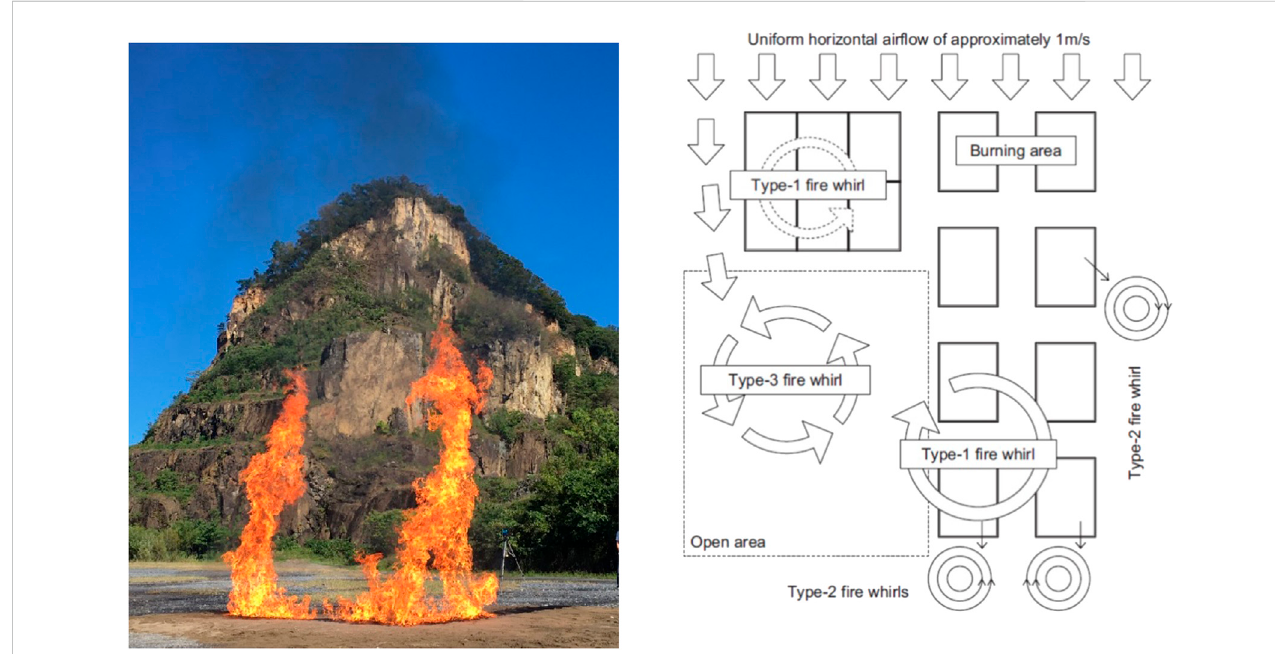
FIGURE 1 Figure 1A Fire whirls formed over an L-shaped line fi re in an open- fi eld experiment (Kuwana et al., 2022) Figure 1B (right) Type-I, II, III fi re whirls (Kuwana et al.,